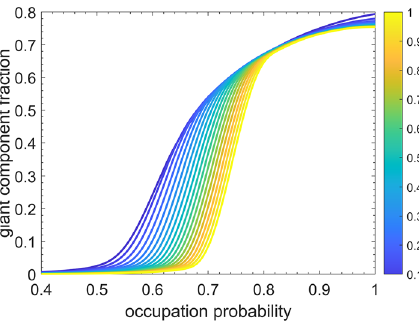
Figure 6. Giant component size with random link occupation for networks of 480 fibers with various cross- linking values as indicated by the line color according to the color bar.